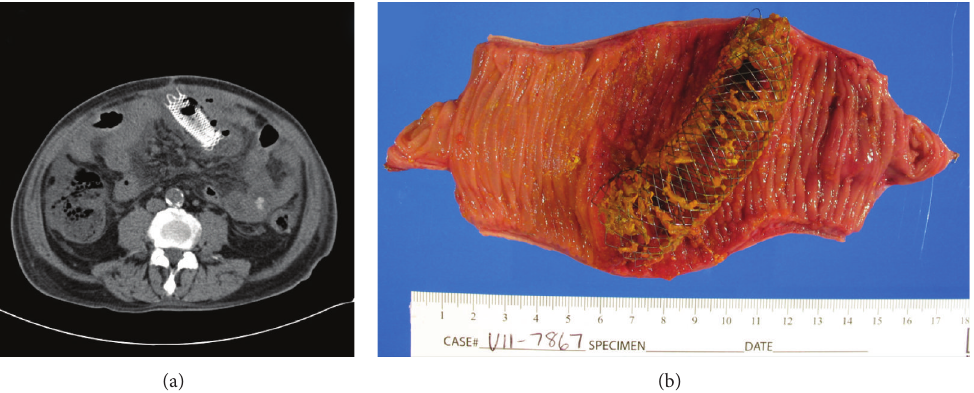
Figure 2: (a) Axial CT image showing migration of the stent distally into the mid-jejunum, with resultant visceral perforation. (b) Surgical specimen showing dislodged enteral stent with perforation of the